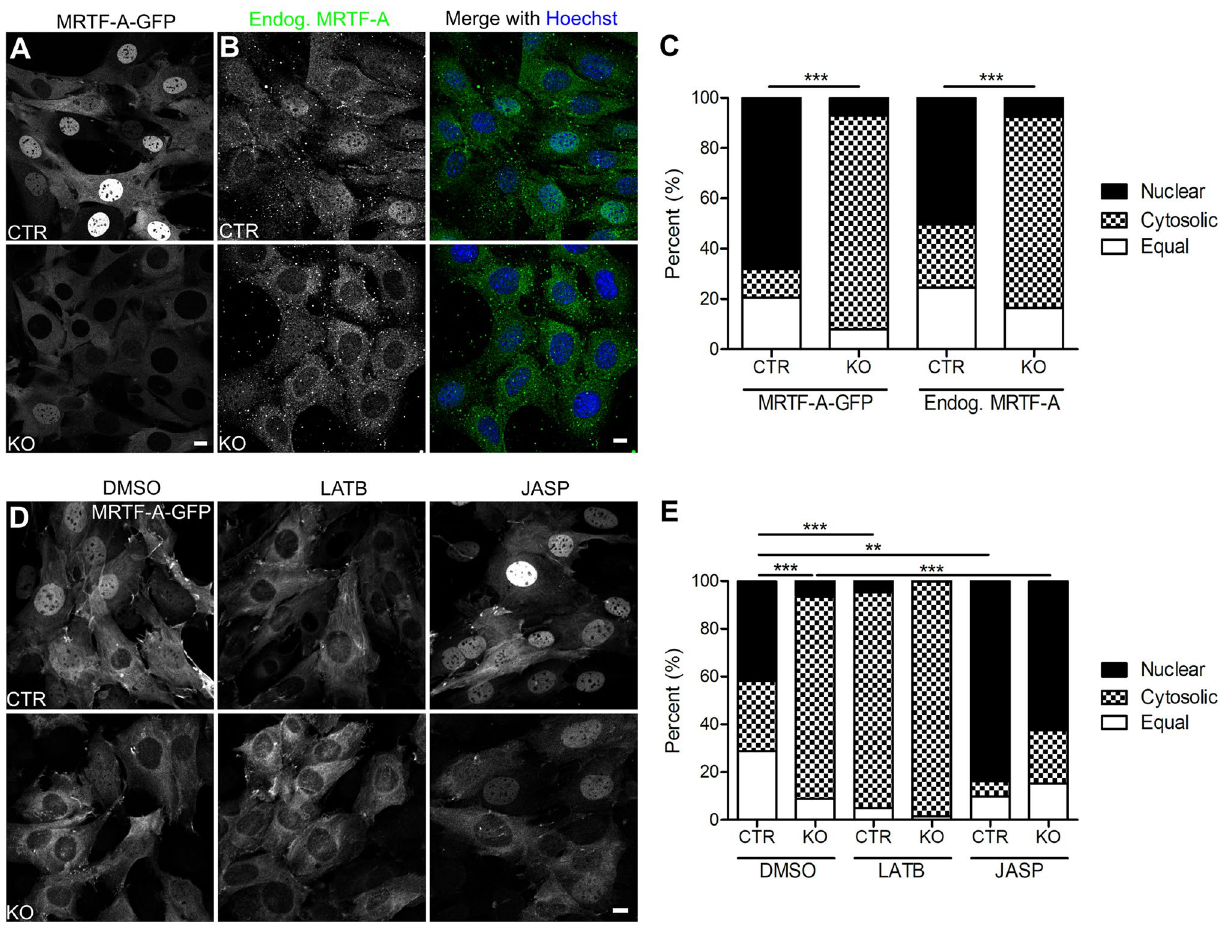
Figure 2. CAP2 controls MRTF-A localization in an actin-dependent manner. ( A ) Representative micrographs of CTR and KO MEFs that stably expressed GFP-tagged MRTF-A (MRTF-A-GFP). ( B ) Representative micrographs of CTR and KO MEFs stained with an antibody against MRTF-A (green). MEFs were counterstained with the DNA-dye Hoechst (blue). ( C ) Categorization of MEFs according to the localization of MRTF-A-GFP or endogenous MRTF-A, i.e. fractions with mainly nuclear or cytosolic MRTF-A-GFP and fraction with equal levels in both compartments. ( D ) Representative micrographs of MRTF-A-GFP-expressing CTR and KO MEFs upon treatment with either DMSO, latrunculin B (LATB) or jasplakinolide (JASP). ( E ) Categorization of MEFs according to the localization of MRTF-A-GFP upon treatment with either DMSO, LATB or JASP. Scale bars (in µm): 10 ( A , B , D ). *P < 0.05, **P < 0.01, ***P < 0.001, ns not